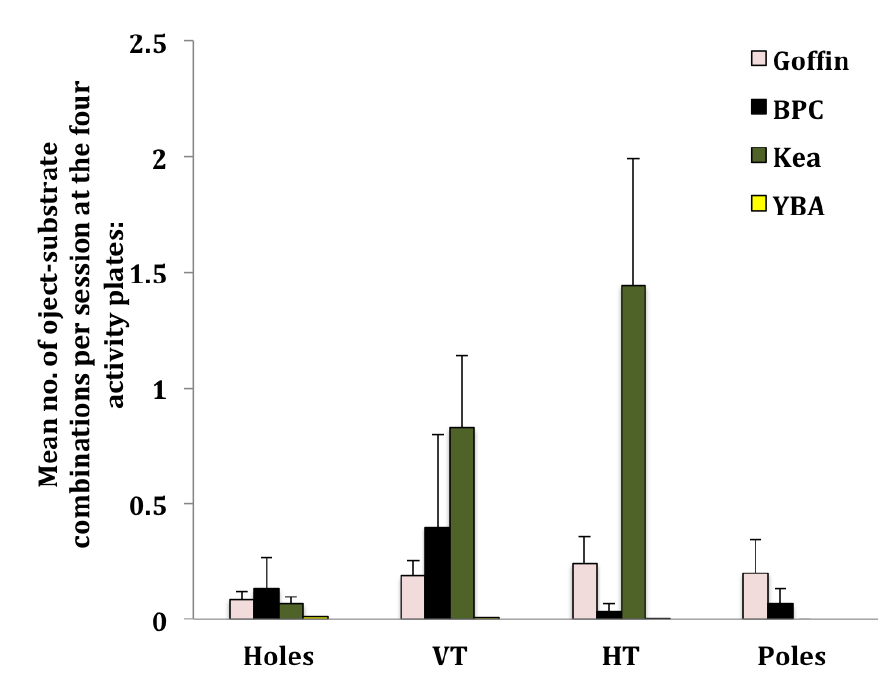
Figure 5. Mean number (  SE) of complex combinations per session at the four activity plates: Holes, VT = Vertical Tubes, HT = Horizontal Tubes, Poles. The colors of the bar charts indicate different species: rose = Goffin ( N = 14), black = BPC ( N = 2), olive = kea ( N = 14), yellow = YBA ( N =